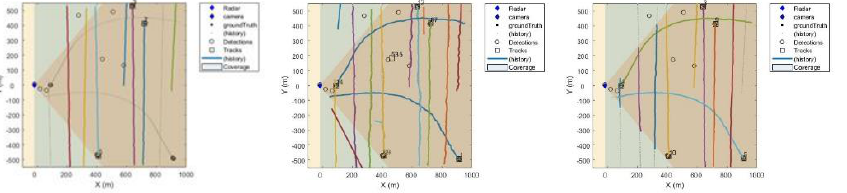
Fig. 4. Local tracks and corresponding OSPA curves from AIS, radar and camera. Left: AIS. Centre: radar. Right: